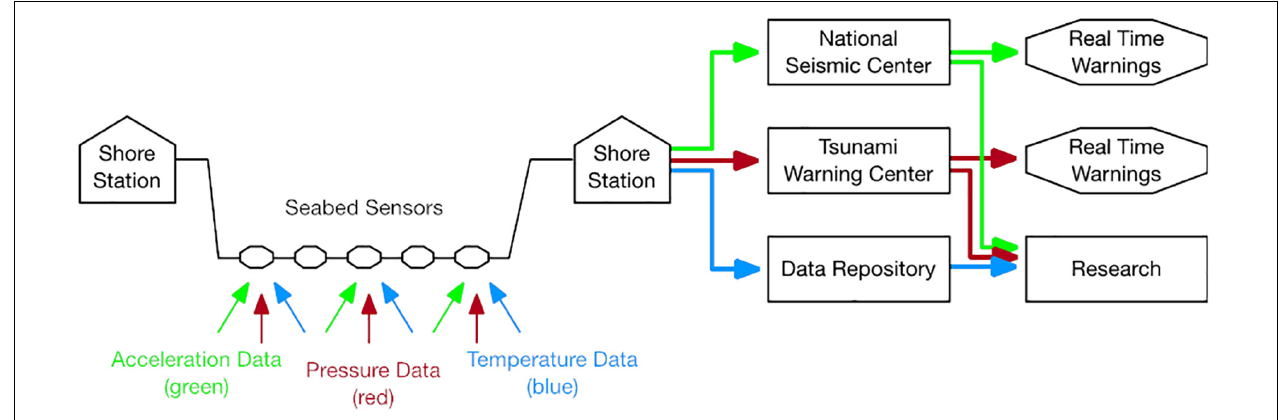
FIGURE 15 | Data flow from SMART cables to end users. Permission obtained for use of